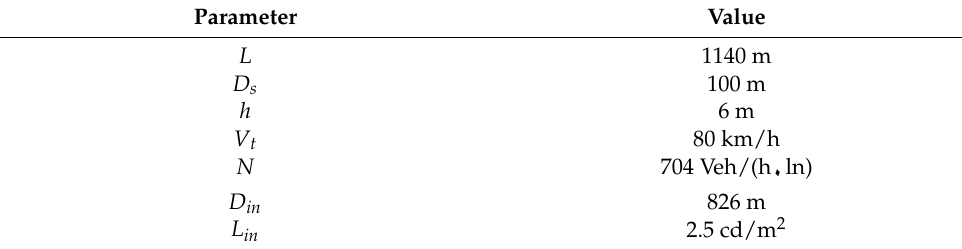
Table 2. Parameters of Xiaogou